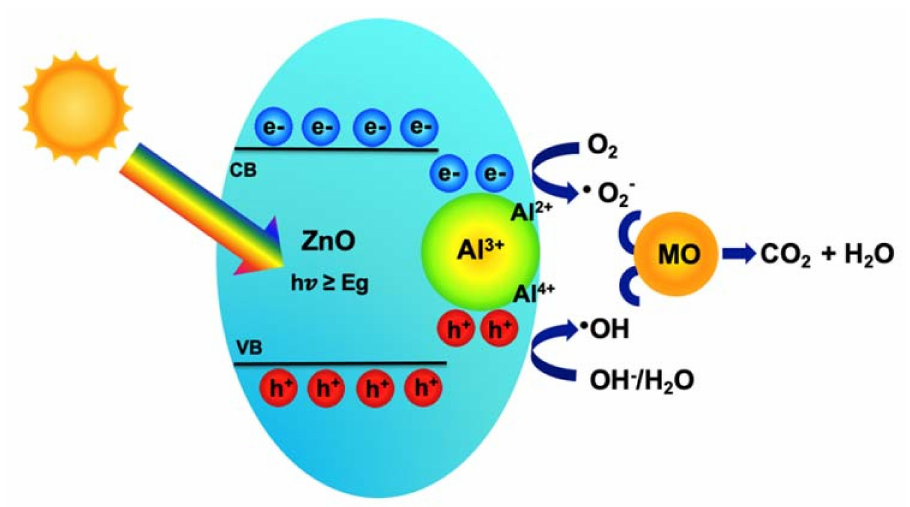
Figure 6. Mechanism of Al/ZnO photocatalyst for MO degradation under light